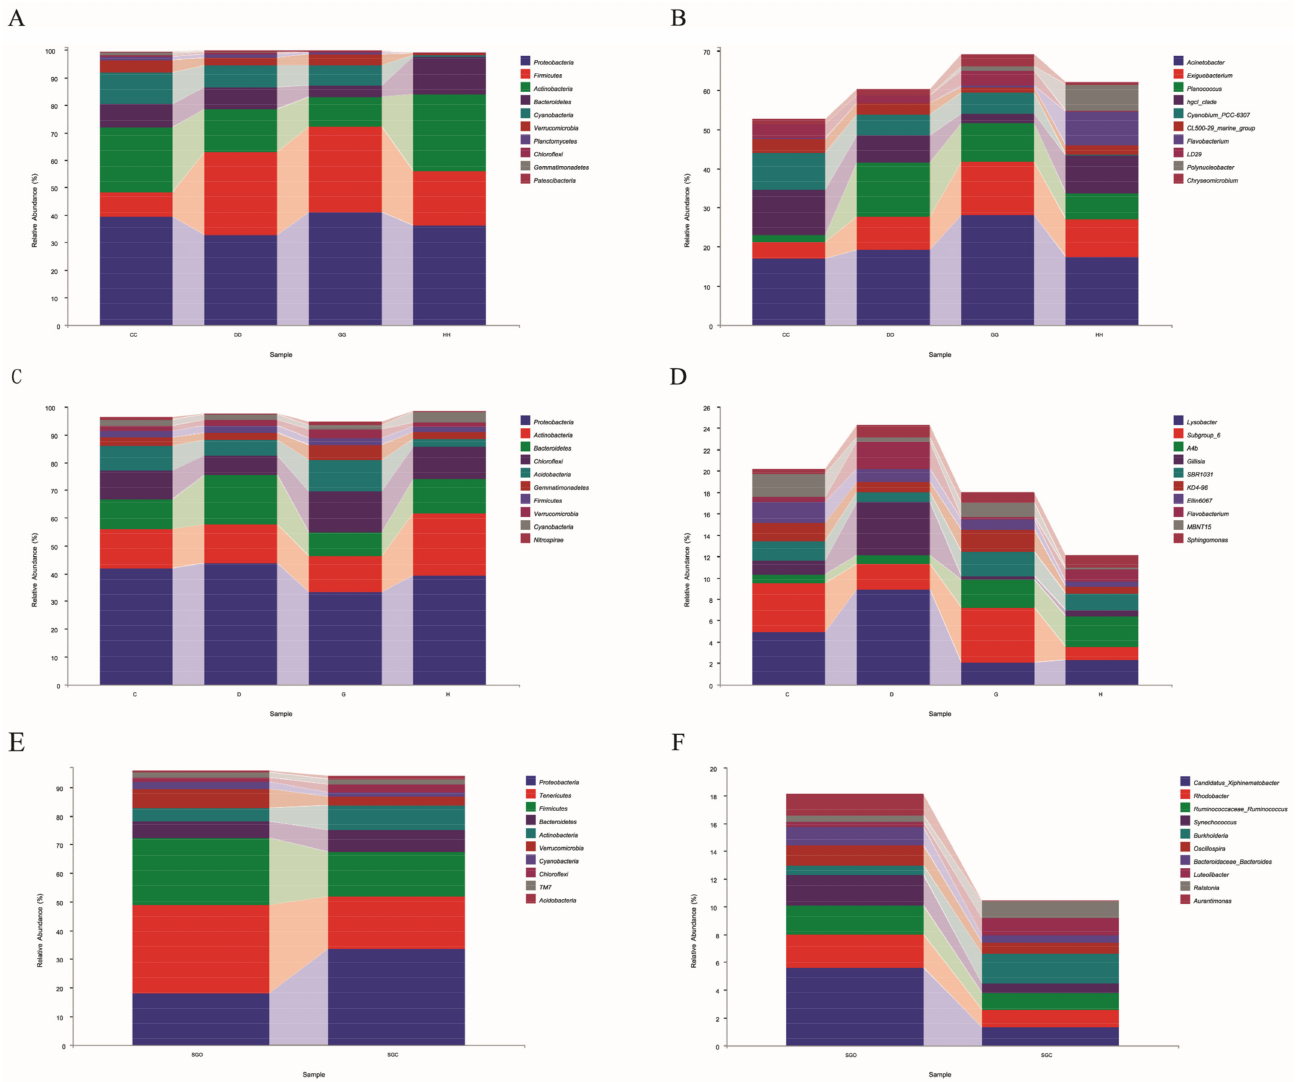
Figure 2. Relative abundances of microbial communities in shrimp farm samples with different oxygenator conditions. ( A ) Phylum level in water. ( B ) Genera level in water. ( C ) Phylum level in sediment. ( D ) Genera level in sediment. ( E ) Phylum level in shrimp gut. ( F ) Genera level in shrimp